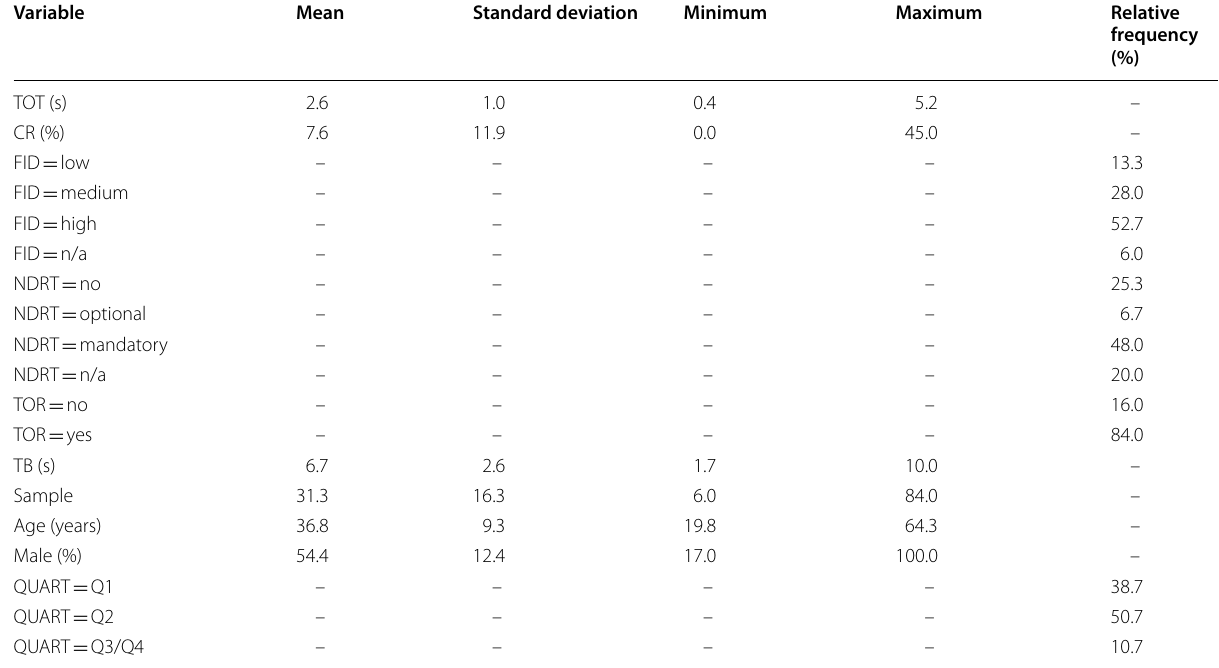
Table 4 Data description for the meta-analysis Variable Mean Standard